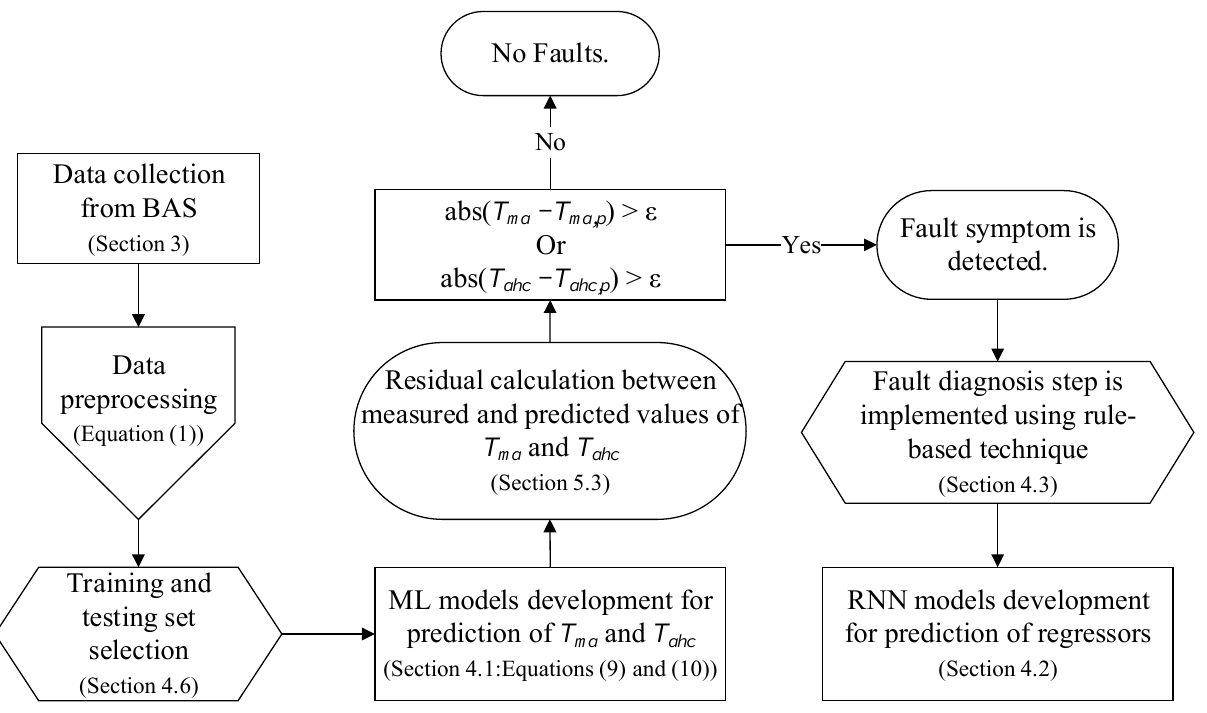
Figure 3 . MDFDD diagram . Figure 3. MDFDD